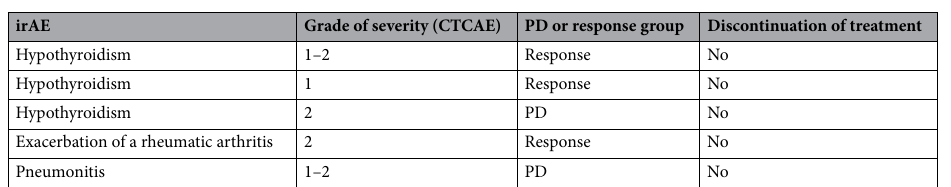
Table 4. Detected irAEs in the study cohort. irAE immune related adverse